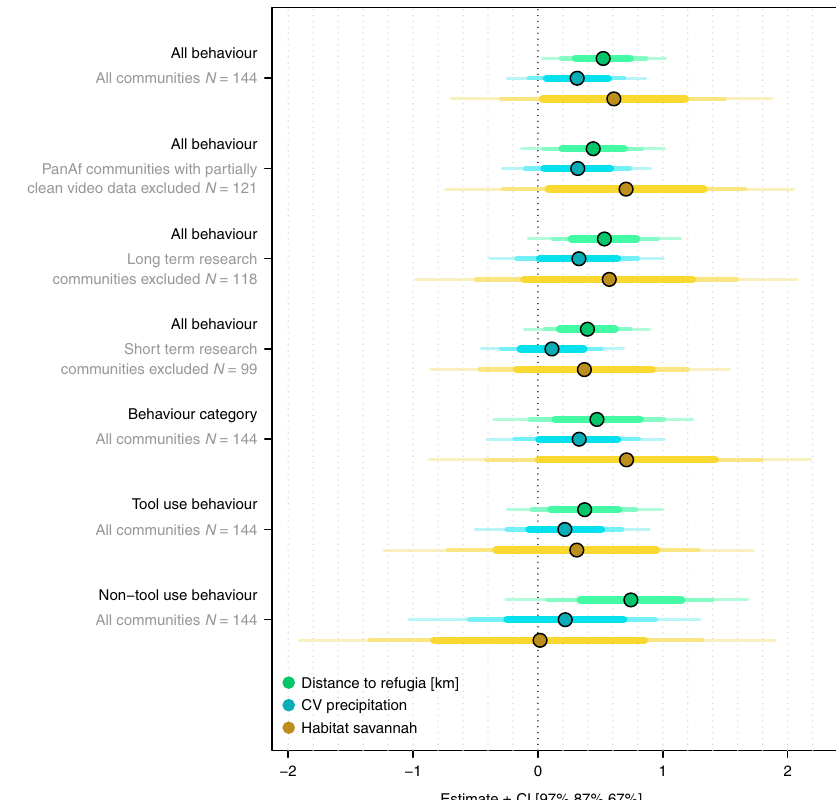
Fig. 3 Effects of all three environmental variability predictors on chimpanzee behavioural diversity. We tested precipitation seasonality, savannah woodland versus forest habitat, and distance to Pleistocene refugia on the probability of occurrence for 31 chimpanzee behaviours as well as various subsets of the data to verify robustness of the results. The plot shows the mean of the marginal posterior distribution (dots) and the 67, 87, and 97% credible intervals centred on the mean (coloured